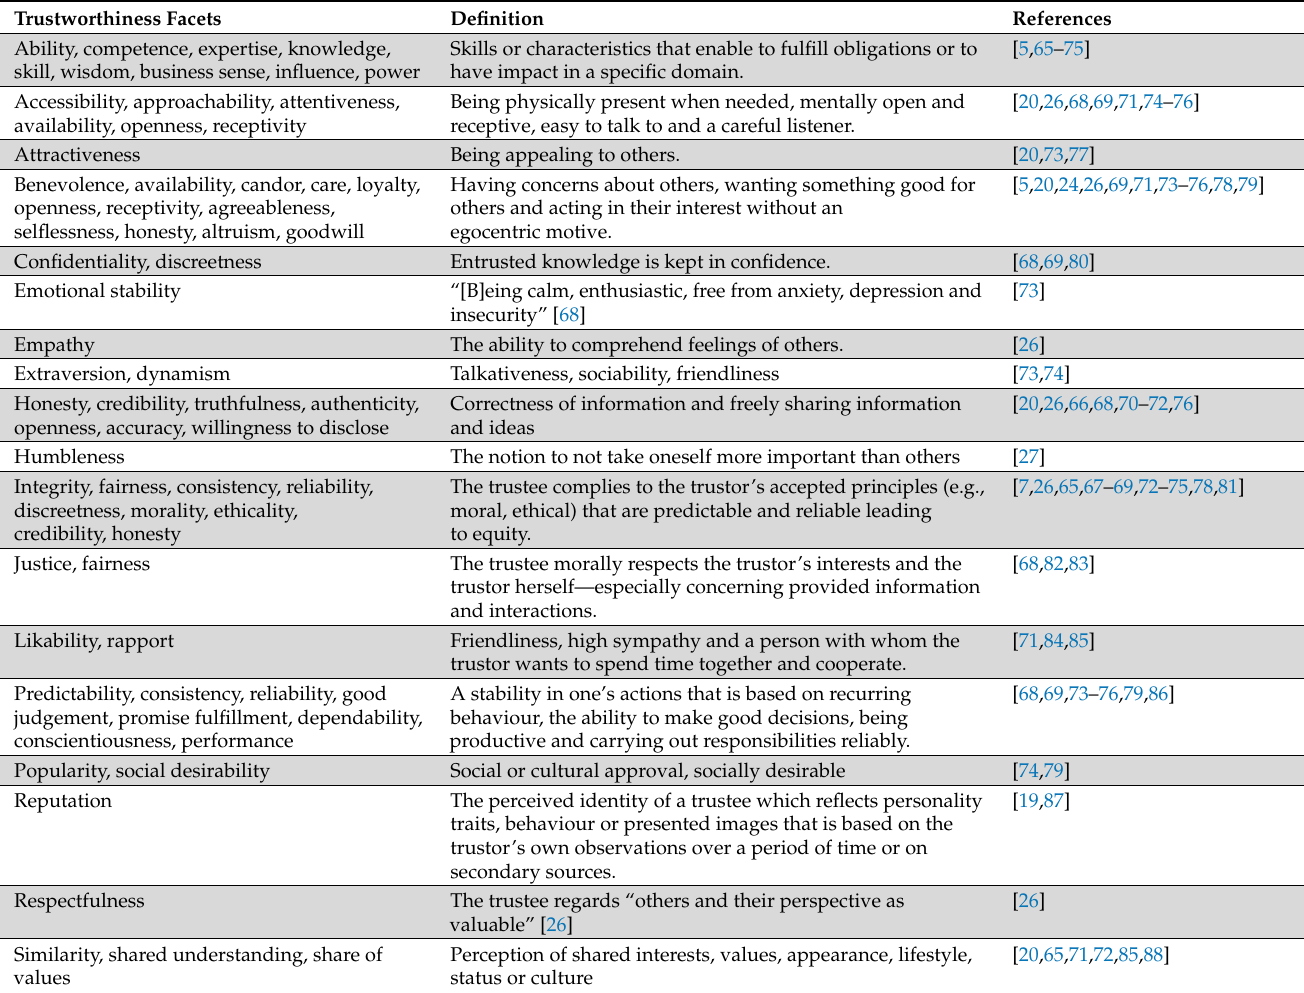
Table A1. Overview of trustworthiness facets of